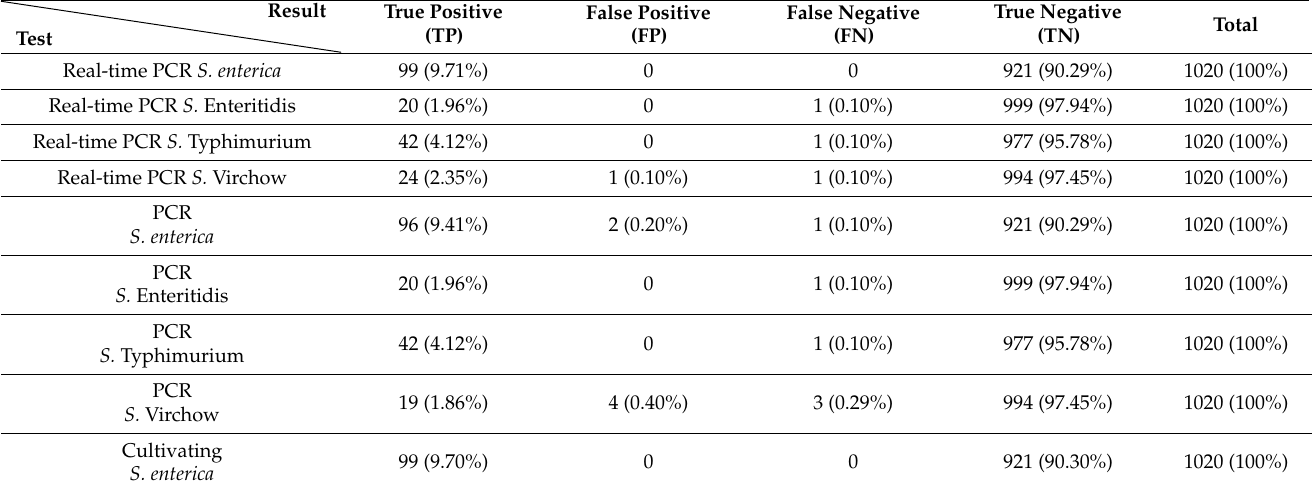
Table 4. Identification of Salmonella enterica and its types S. Enteritidis , S. Typhimurium, and S. Virchow in samples using various tests.